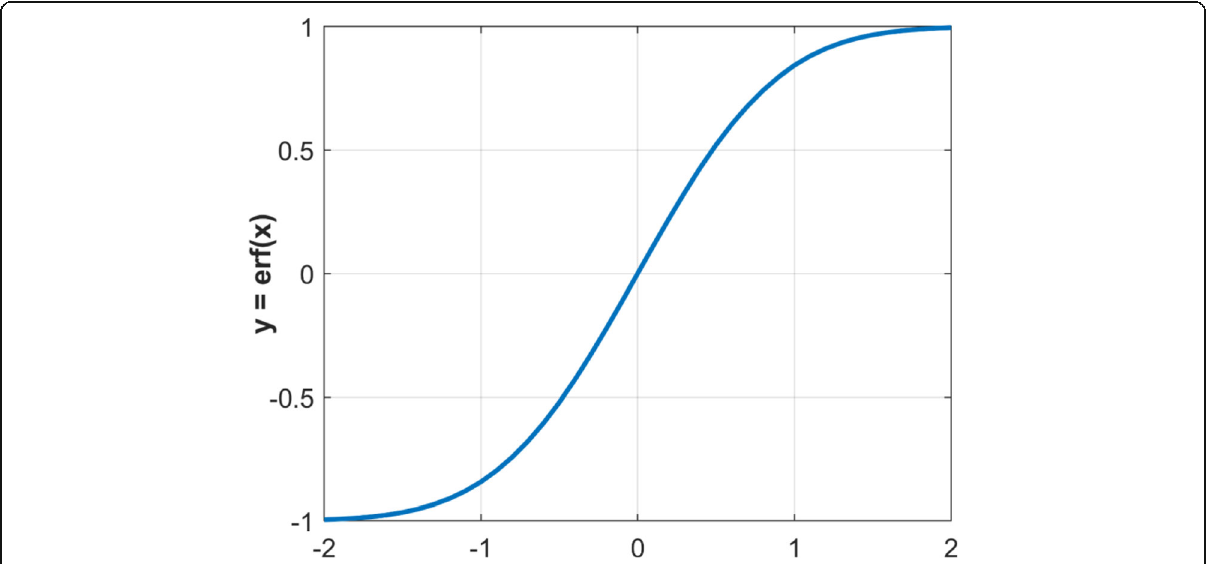
Fig. 3 Gaussian error function waveform: the waveform of Gaussian error function whose midpoint is